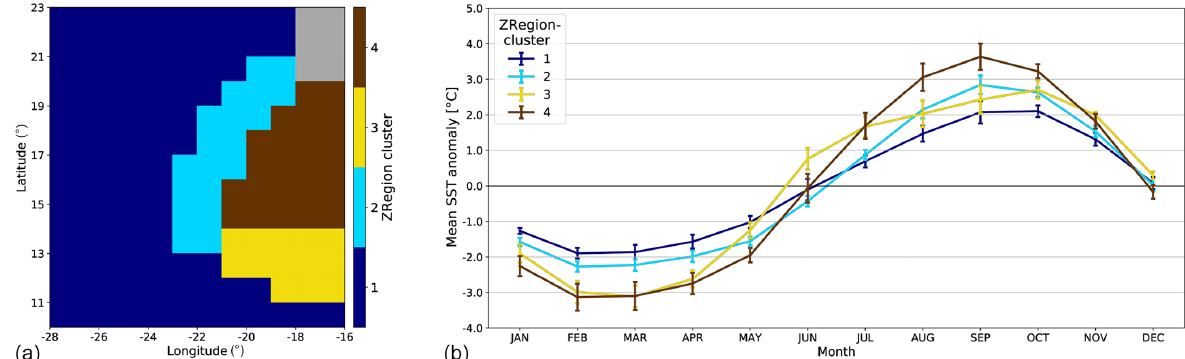
Figure 7. (a) ZRegion clusters associated with the ZSOM clusters obtained after a HAC on a 10 × 12-neuron SOM learned on ERSSTv3b observations in the zoomed zone (see text for details). (b) Ensemble-mean monthly climatological SST anomalies for the grid points of the four ZRegion clusters. The error bars show the standard deviation of this ensemble mean.